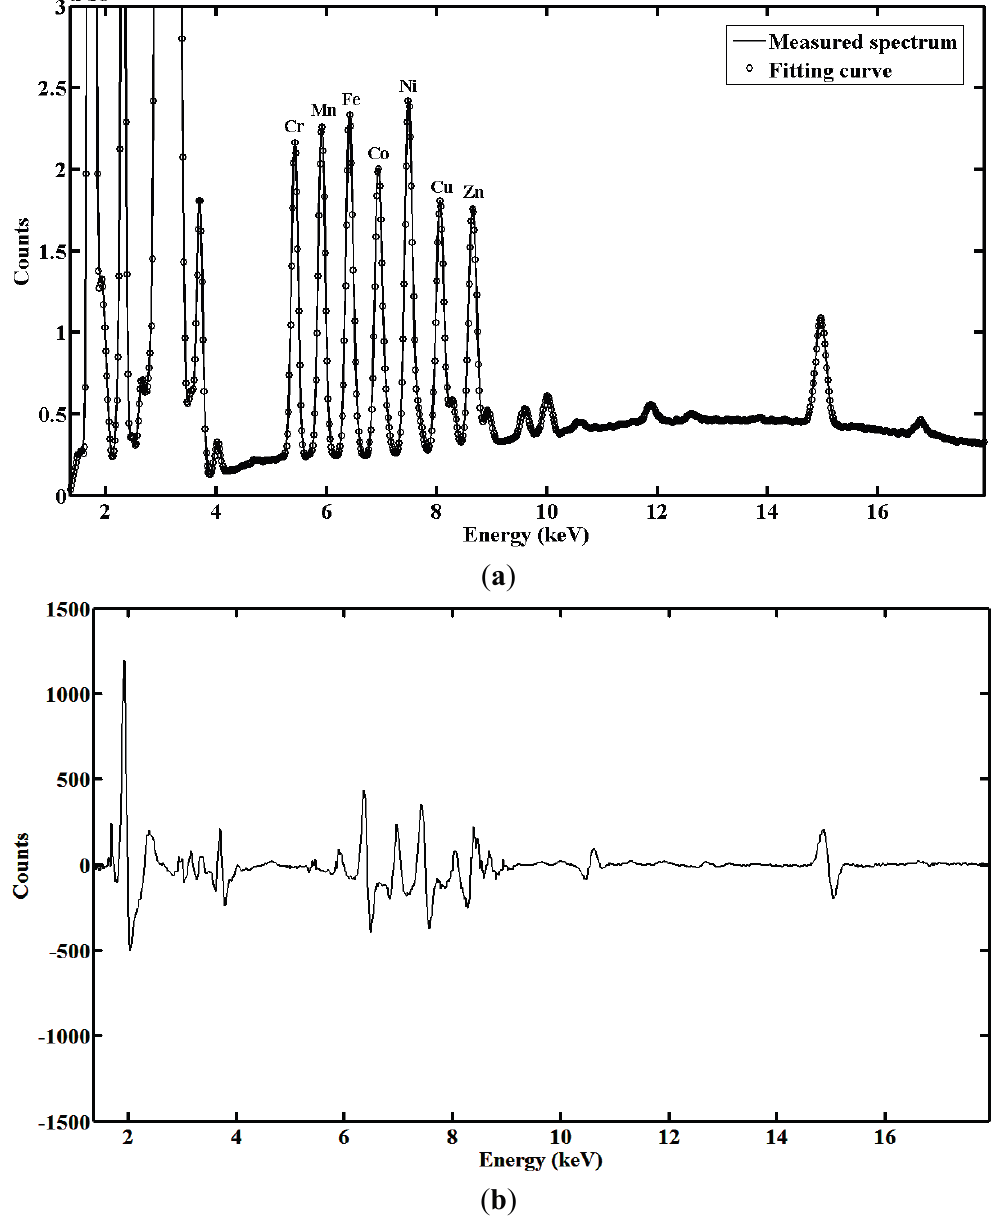
Figure 6. Fitting curve of measured spectrum obtained by PSO-RBFN-SA. ( a ) Comparison between measured spectrum and its fitting curve; ( b ) Fitting residual